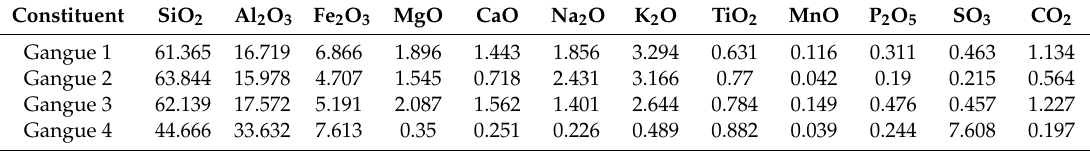
Table 4. Main chemical constituents of Coal Gangue 1–4 after AMD repair by dynamic experiment